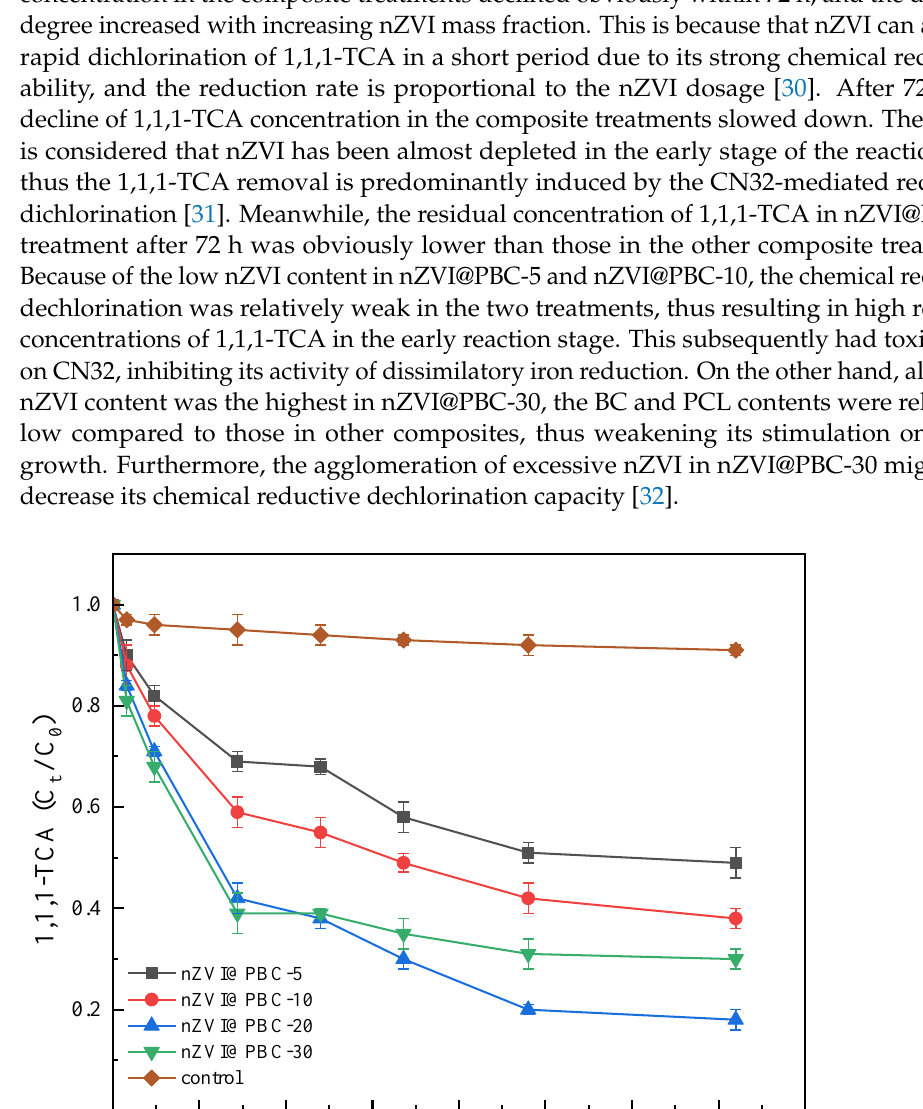
7 of 16 Table 1. Pore structure characteristics of nZVI@PBC. Sample 3.542 The synergy effects of the four composites and Shewanella putrefaciens CN32 on the removal of 1,1,1-TCA (100 mg·L −1 ) from simulated groundwater are shown in Figure 5. At the end of the culture period, the removal rate of 1,1,1-TCA in the different composite treatments (58.79–75.27%) was significantly higher than that in the control group without composite addition (12.3%). This indicates that the composites produced in this study had good performance on 1,1,1-TCA removal from groundwater. Specifically, the 1,1,1-TCA concentration in the composite treatments declined obviously within 72 h, and the de-